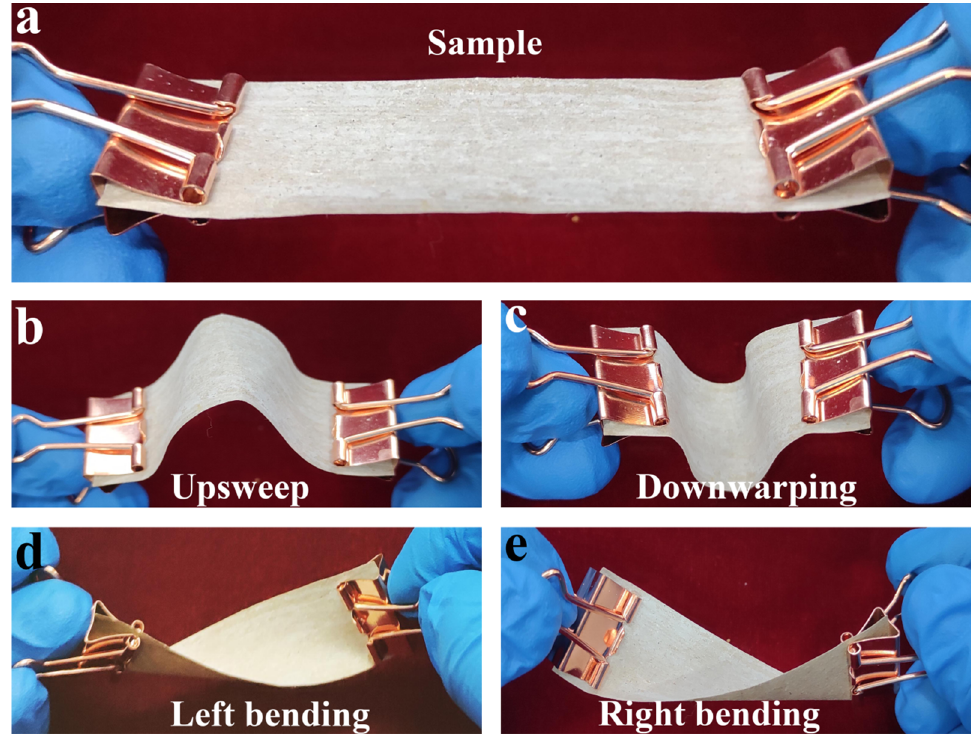
Figure 7. ( a ) Sample diagram before mechanical property test, ( b ) Upward bending diagram, ( c ) Downward bending diagram, ( d ) Left-side upward twisting diagram, ( e ) Right-side upward twisting diagram.